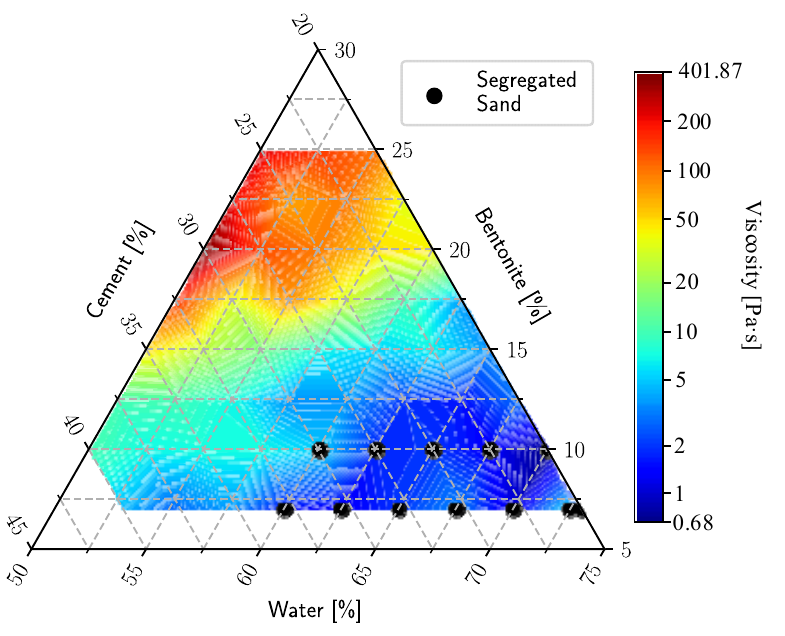
Figure 4. Contraction cracking caused by high water content.